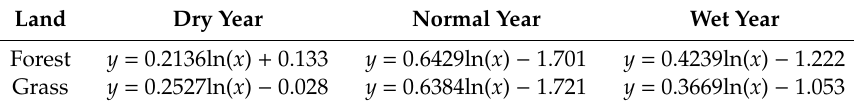
Table 5. The reduction function of sediment by forestland and